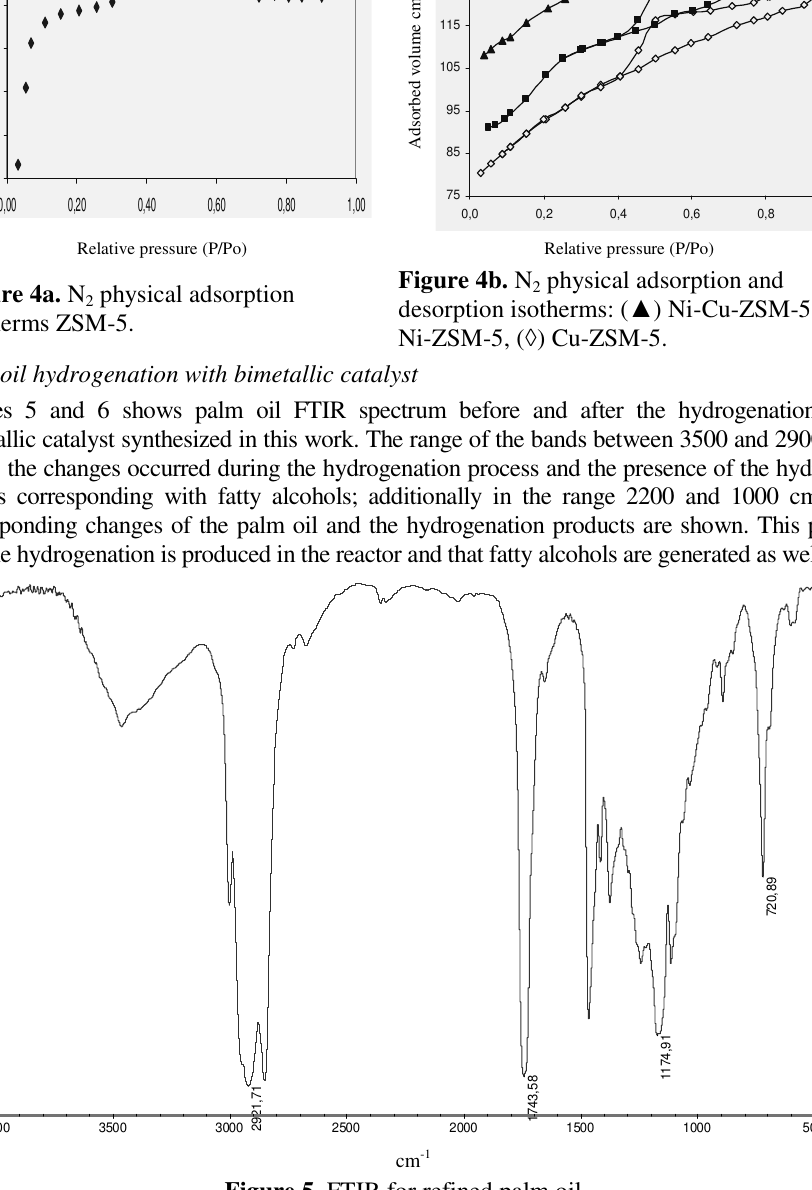
Figure 5. FTIR for refined palm